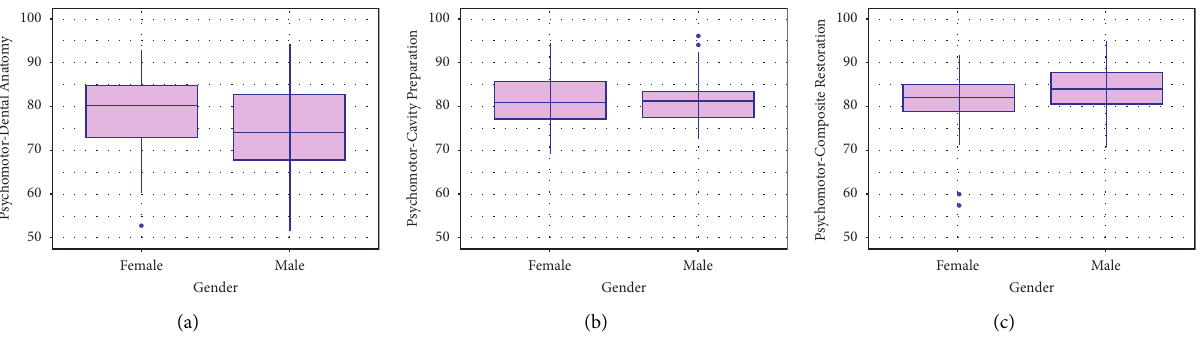
Figure 2: Box plots of the dental anatomy and operative psychomotor silks for male and female students. (a) Dental anatomy psychomotor skills for male and female students. (b) Cavity preparation psychomotor skills for male and female students. (c) Composite restoration psychomotor skills for male and female Table 1: Pearson’s correlation matrix and p values for dental anatomy and preclinical operative dentistry didactic and psychomotor skills percentage scores for male and female students combined.